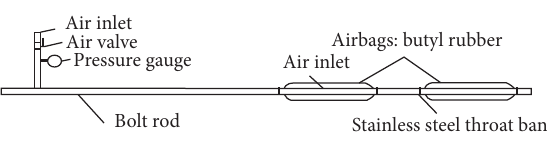
Figure 1: The polycystic aeration bolt